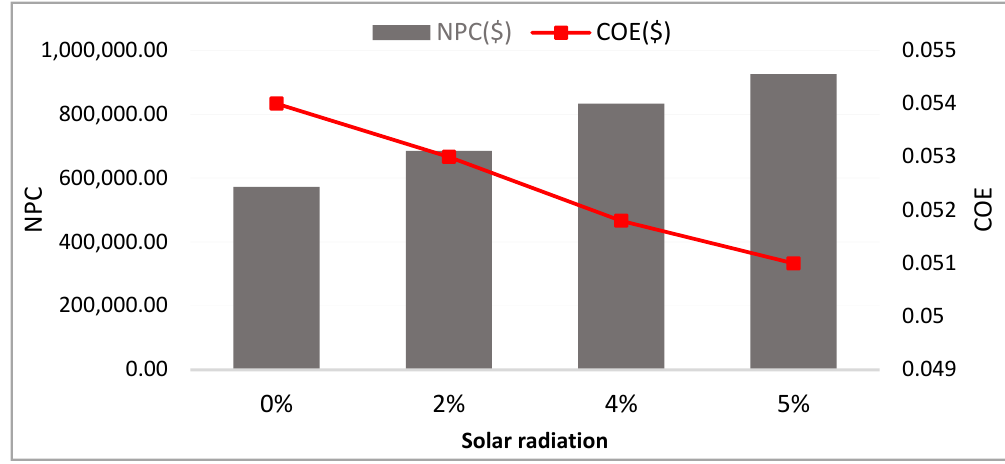
Figure 17. Solar radiation effects on COE and NPC.